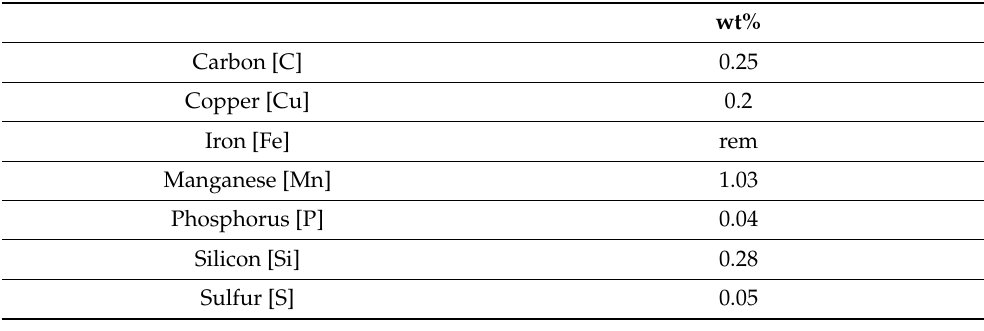
Table 2. Composition of steel panels.